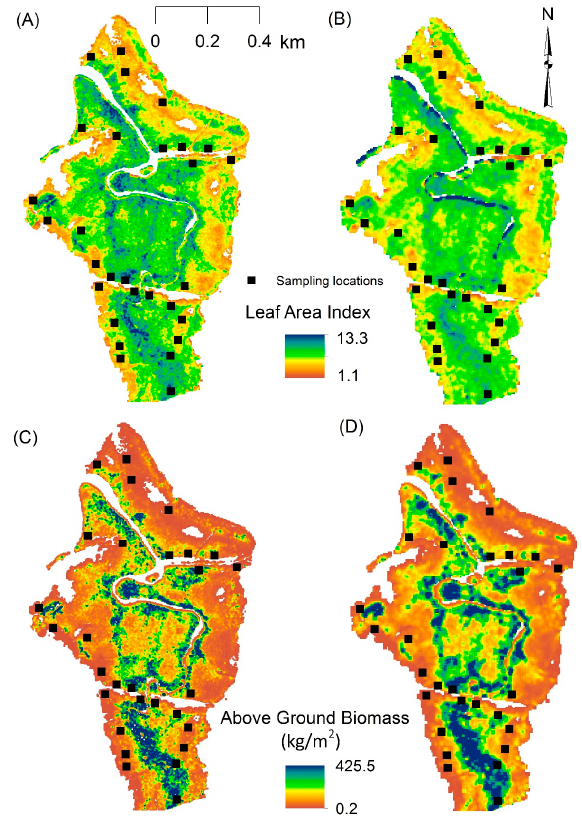
Figure 5. Predicted maps: ( A ) leaf area index with a 2-m spatial resolution; ( B ) leaf area index with a 5-m spatial resolution; ( C ) above ground biomass with a 2-m spatial resolution; and ( D ) above ground biomass with a 5-m spatial resolution; using the partial least squares regression algorithm. The distribution of field sampling plots is shown in the maps (the sizes of the black squares are not to scale).